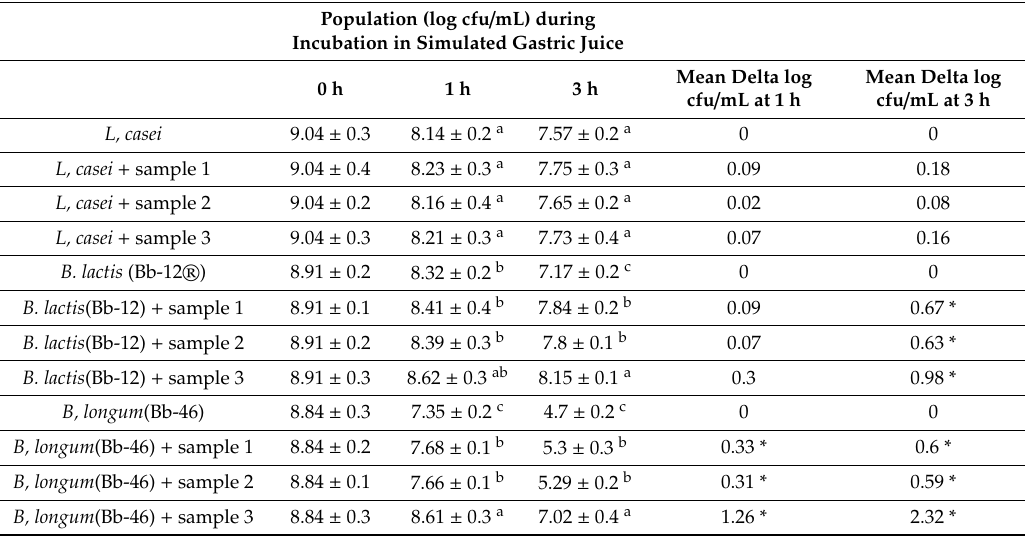
Table 4. Population (log cfu / mL) of probiotic bacteria in simulated gastric juice medium without (control) or with the addition of encapsulated Goji berry extracts (samples 1–3).